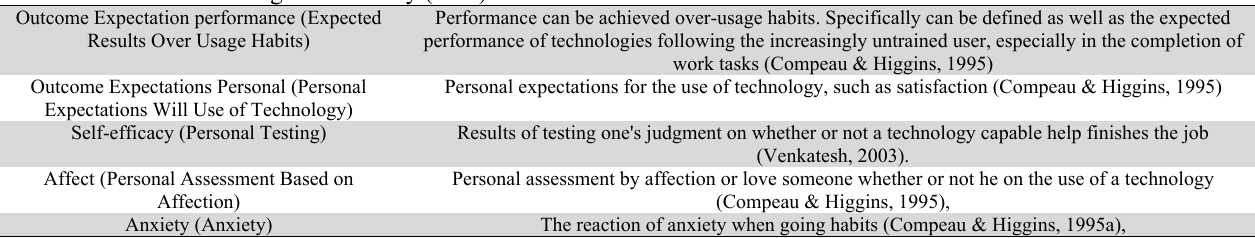
Model Construct Social Cognitive Theory (SCT)